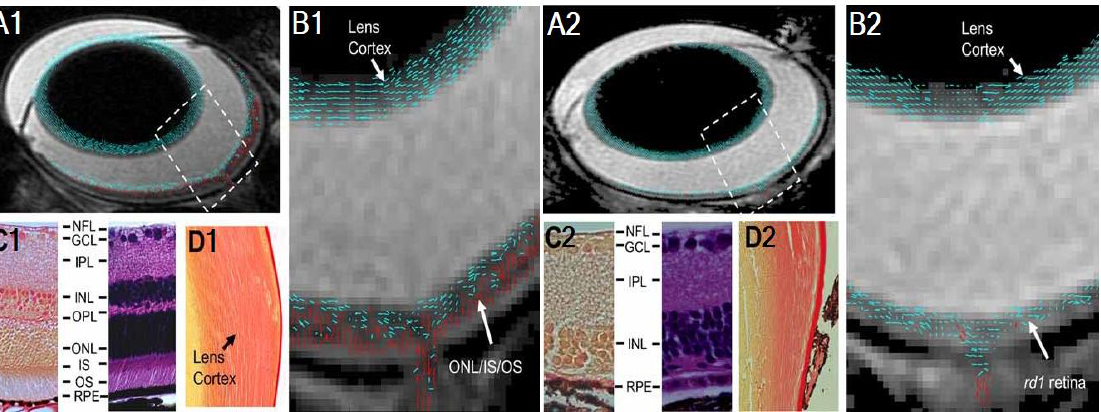
Figure 3. Reduction in fractional anisotropy in the outer retinal layers of rd1 mice ( A2 , B2 ) relative to wild-type controls ( A1 , B1 ) (red vectors), consistent with histological evidence of photoreceptor layer deterioration. Images are adapted with permission from Chen et al. [64].